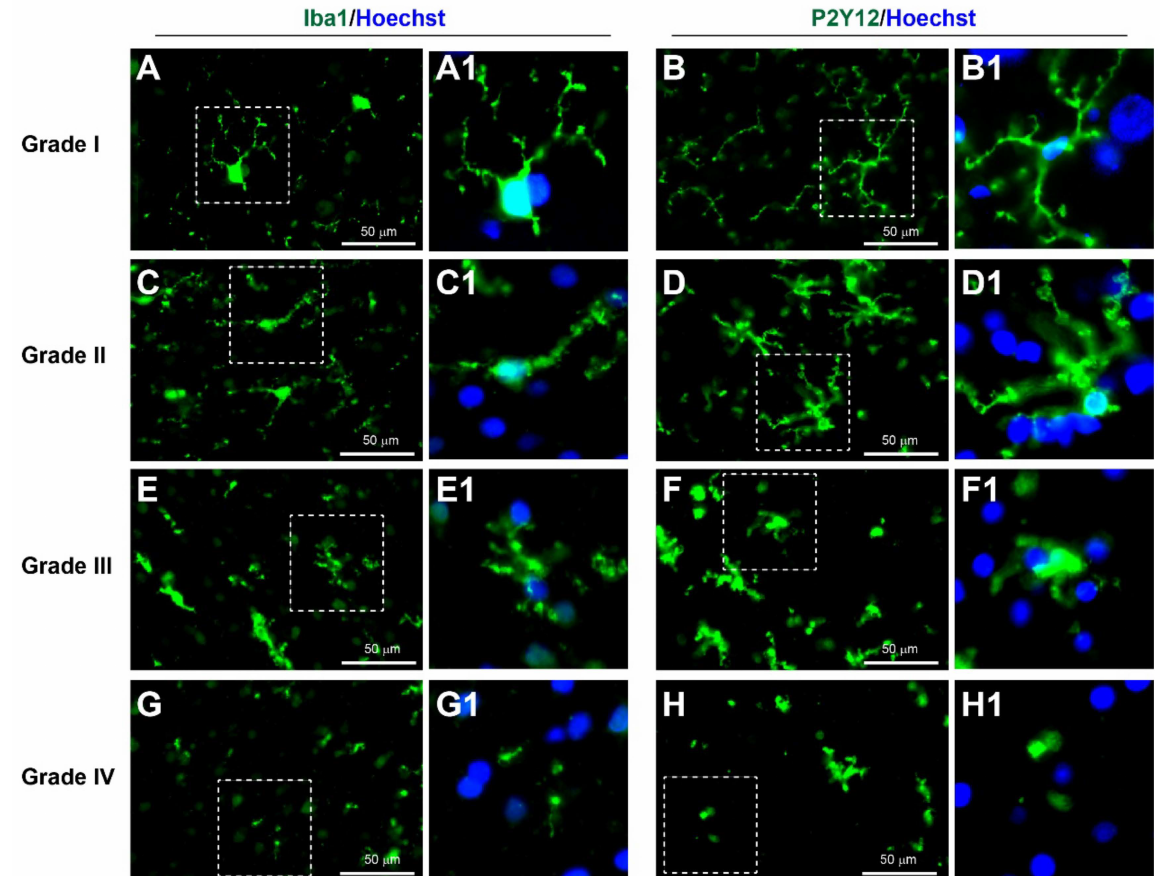
Figure 5. YHU grading system for neuroinflammation in cerebral biopsies immunostained with Iba1 (green, left panels), P2Y12 (green, right panels), and Hoechst (nuclei, blue). ( A – B1 ) Microglia exposed to limited brain injury display a ramified appearance with long and thin processes and moderate expression of either iba1 or P2Y12 (grade I). ( C – D1 ) Mild brain injury induces neuroinflammation with increase in microglial Iba1 and P2Y12 expression and thickening of processes (grade II). ( E – F1 ) In moderate neuroinflammation, the microglia display an ameboid morphology with very short processes (grade III). ( G – H1 ) In severe brain injury, few, if any, intact microglia are present, and